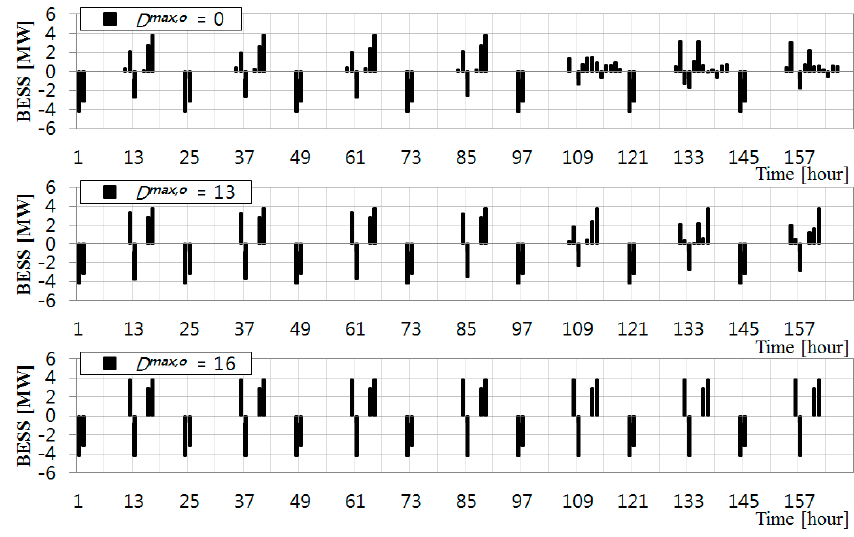
Figure 8. Weekly schedules of ESS for the customer electric bill minimization.